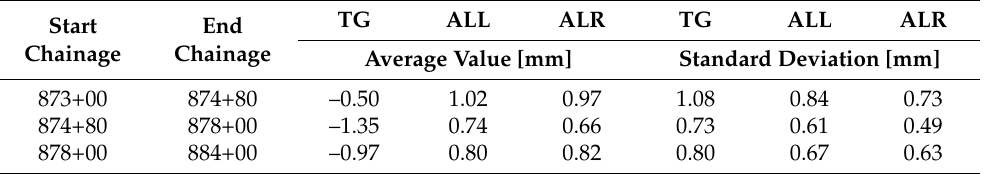
Table 3. Average and deviation of track parameters (section No. 2).